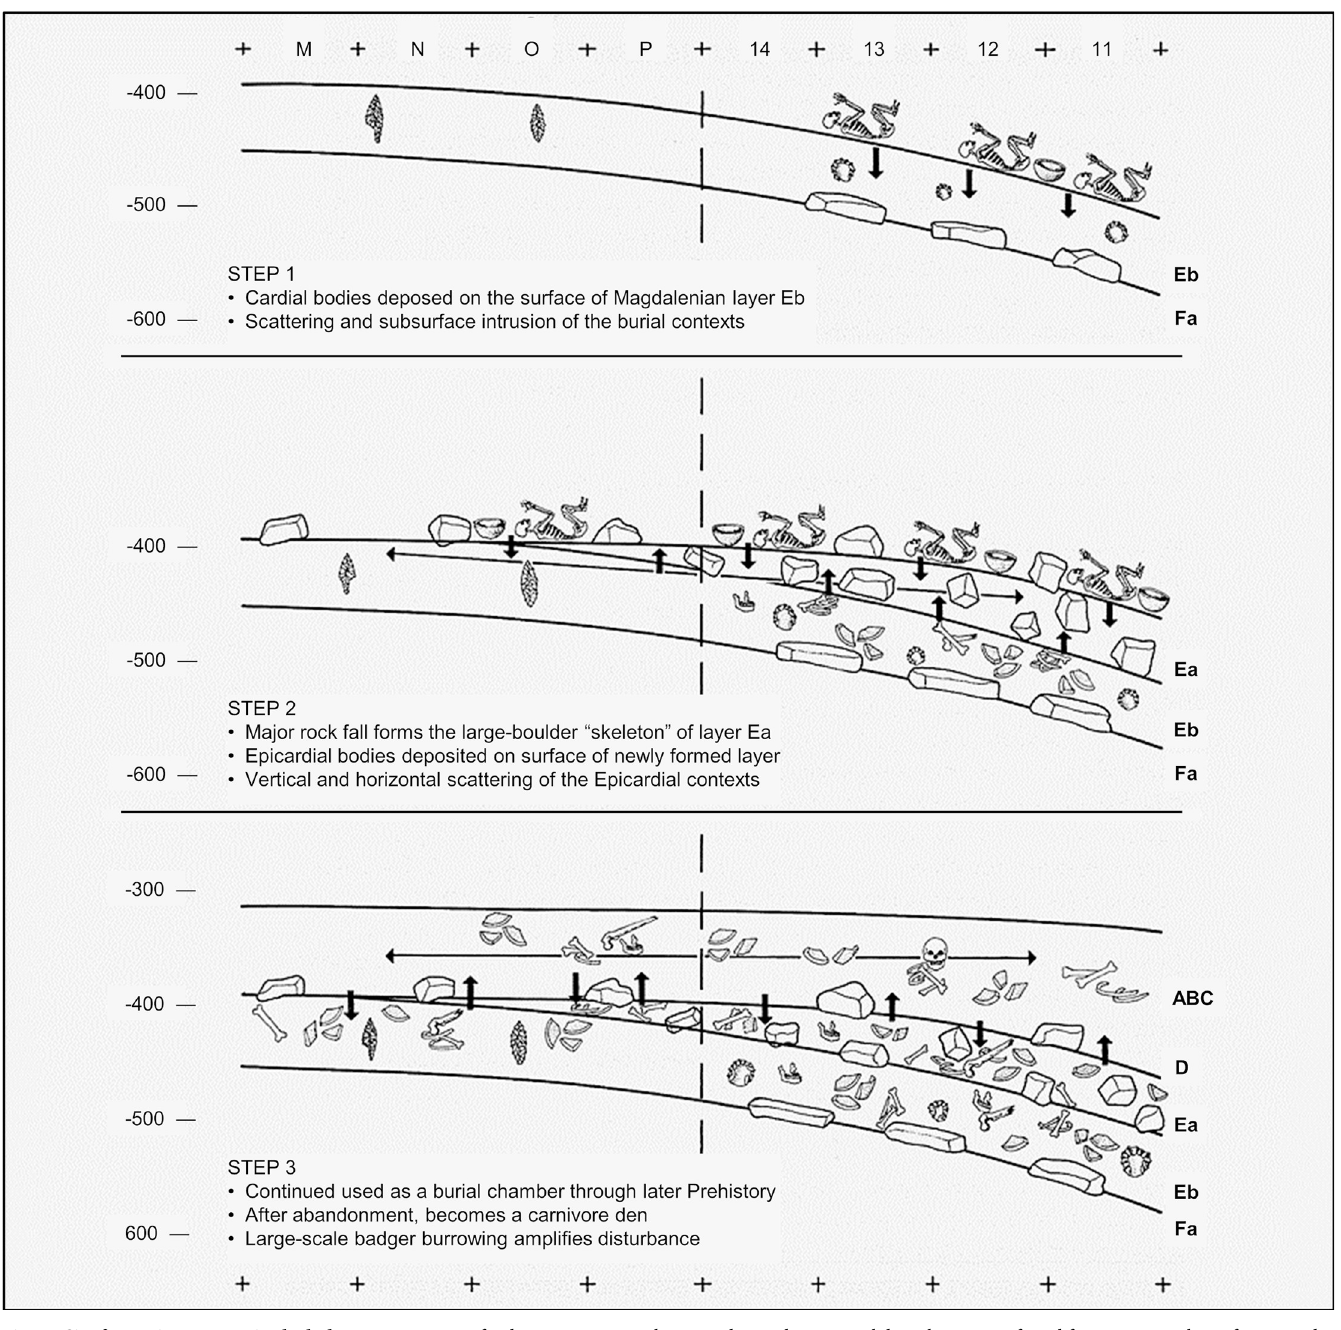
Fig 21. Site formation process in the holocene. Processes of sedimentary accumulation and post-depositional disturbance as inferred from stratigraphy, refitting, and spatial distributions (modified after Fig 3.11 of [1]). https://doi.org/10.1371/journal.pone.0259089.g021 ever more deeply buried, and the densely packed e´boulis forming the skeleton of layer Ea pro- vided additional protection against disturbance by large burrowers. That must be the reason why the upper part of layer Eb contained the odd sherd of post-Cardial pottery in the Corridor but not in the Back Chamber. Potsherd refitting does show, however, that, in later Neolithic